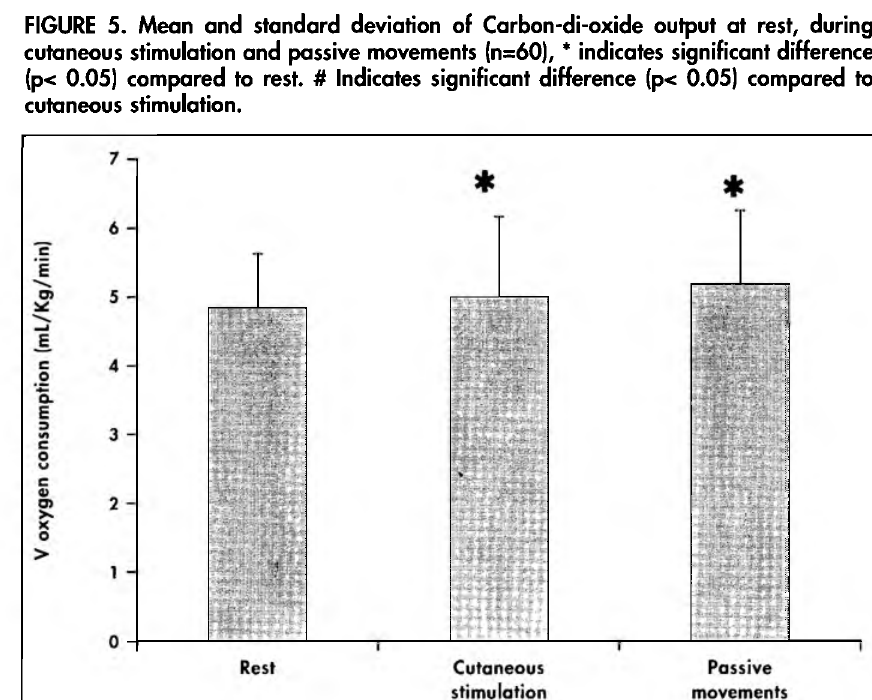
FIGURE 5. Mean and standard deviation of Carbon-di-oxide output at rest, during cutaneous stimulation and passive movements (n=60), * indicates significant difference (p< 0.05) compared to rest. # Indicates significant difference (p< 0.05) compared to cutaneous